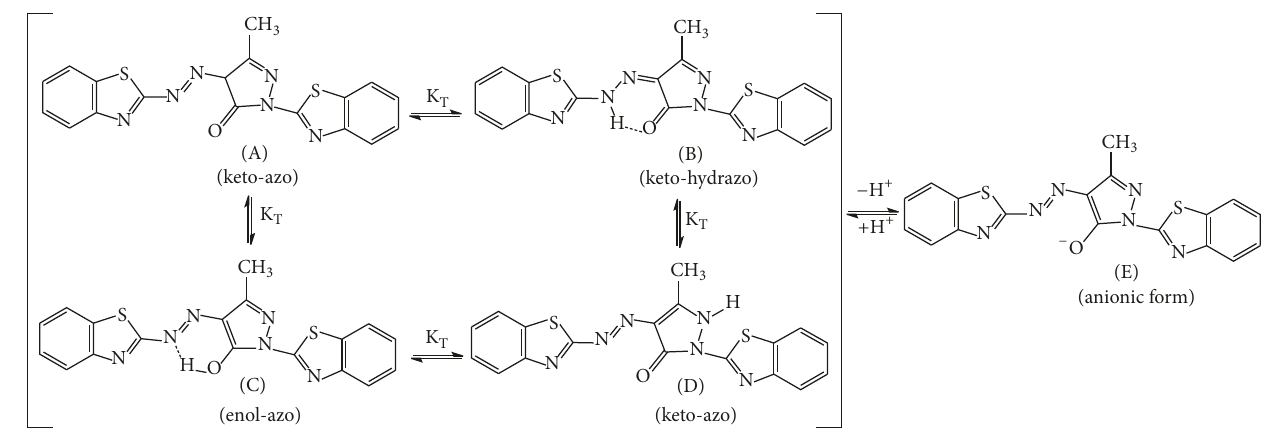
Figure 2: Tautomeric equilibrium of dye 3a.